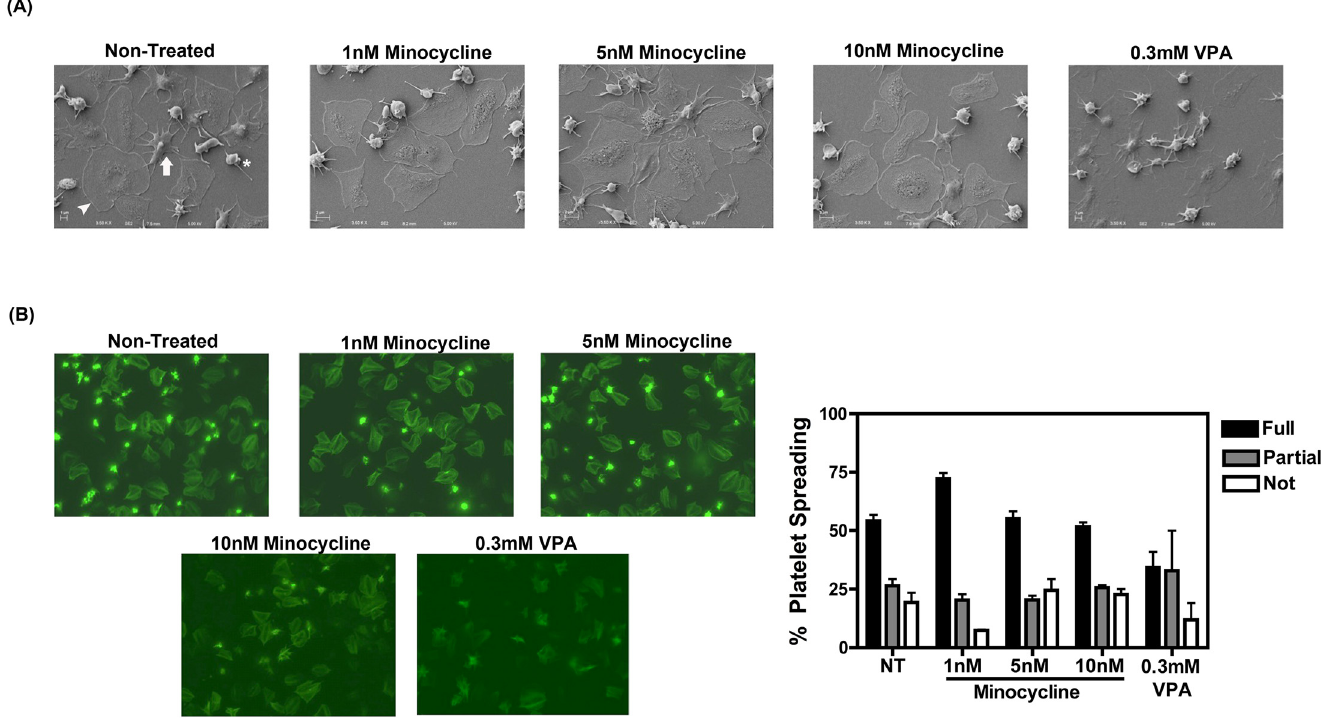
Fig 3. Minocycline does not affect platelet spreading. (A) Platelets were incubated with various concentrations of minocycline or 0.3mM VPA, and subsequently spread on fibrinogen-coated glass coverslips. Platelet morphology via SEM imaging is denoted as not spread (asterisk), partially spread with filopodia but not lamellopodia (arrow), or fully spread with lamellopodia (arrow head). (B) Platelets were again treated with minocycline or VPA, and spread on fibrinogen coated coverslips. Platelet spreading was assessed and quantified based on cellular morphology as described in (A). Data is representative of three separate experiments and was analyzed using a one way ANOVA statistical test. Phalloidin (green) staining of F-actin cytoskeleton was used to aid in visualization.